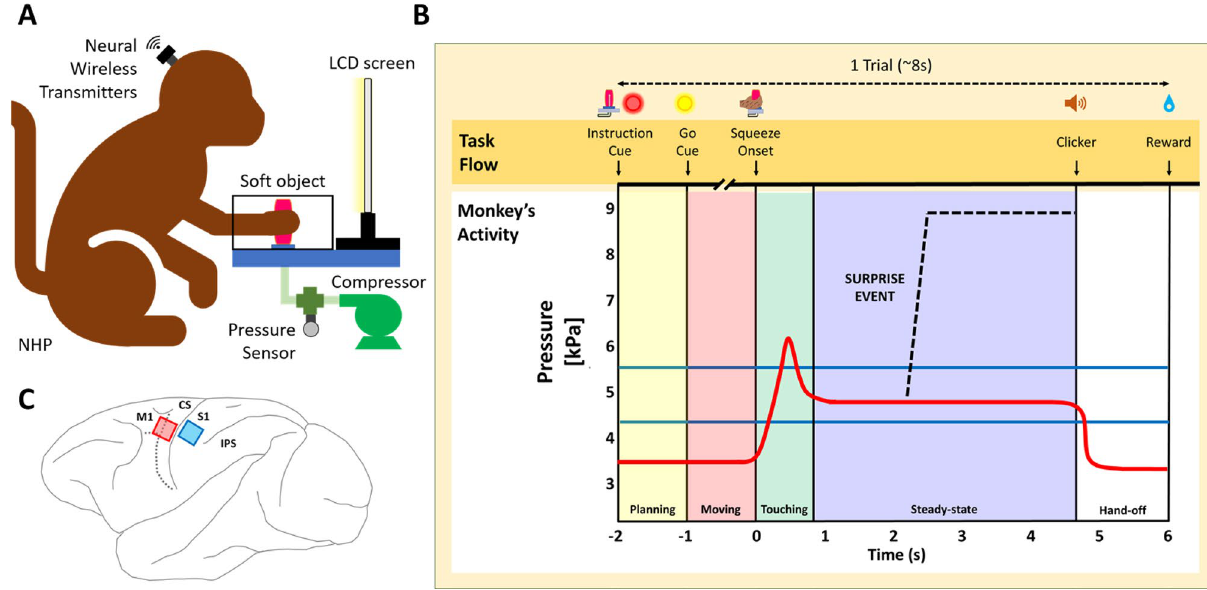
Figure 1. Experimental design. ( A ) Schematic of the experiment. Central to the design is a compliant cylindrical manipulandum composed of a soft polymer envelope which is internally pressurized from a hydraulic air compressor. The monkey sits in a custom-made chair and reaches for the manipulandum through an opening in a transparent window. Multichannel signals are collected simultaneously from a pair of microelectrode arrays (MEAs in S1 and M1) and transmitted wirelessly to nearby neural signal processing electronics. ( B ) Time course of the task. Top: Graphical representation of task flow. The task flow is separated into four stages: Movement Planning (Yellow rectangular panel), Movement, i.e. arm/hand reach (Pink panel), Touch and Grasp (Green panel), and Steady State squeeze (Blue panel). The solid red line represents trial averaged time varying pressure inside the manipulandum as the monkey first grasps and then squeezes the manipulandum to reach a steady-state. In addition to this ‘NORMAL’ task, the dashed black line shows schematically an abrupt elevation in the internal pneumatic pressure of the manipulandum introduced during the steady state, labeled as the ‘SURPRISE EVENT’ the onset of which was randomly timed from 2–5 s after the onset of Touch. The two blue horizontal lines define the target pressure range within which the monkey must maintain the force of hand squeeze in steady state to complete a successful trial. ( C ) Schematic of the approximate cortical location of the implanted intracortical MEAs. CS central sulcus, IPS intraparietal sulcus, M1 primary motor cortex, S1 primary somatosensory resting position for at least 1 s for the juice reward to start. The intertrial interval was 2–4 s. A trial was consid- ered successful if the monkey could complete all the steps. The monkeys were able to learn and adapt to the task quickly after a few weeks of training and were considered trained in this ‘NORMAL’ task if their performance was above 80% for 5 consecutive days. Once the monkeys were routinely performing the NORMAL task, we introduced an abrupt confound, unbe- knownst to the animals, in a series of random trials. The confound was a sudden reduction in the compliance of the manipulandum during the steady squeeze (dashed line in Fig. 1B) induced by increasing the level of the internal pressure in the manipulandum by approximately 4 kPa from its baseline value within ~ 200 ms and without any visual or auditory cue to the animal. Following this “SURPRISE EVENT”, the monkeys had to re-adjust the force of their squeeze to adapt to the new state of compliance so as to reach and maintain a new steady squeeze for up to another five seconds (guided by the LCD pressure indicator). The new acceptable range was 8–10 kPa, allowing for variability in the excess pressure applied to the manipulandum. The thick horizontal black stripe and the red indicator ball displayed on the LCD screen were shifted to new positions, accordingly. Intracortical microelectrode arrays. Following the training, each monkey was implanted with two 100-element microelectrode arrays (MEA, Blackrock Microsystems, Salt Lake City, UT, USA) targeting the hand representation of the primary somatosensory (S1) and the primary motor (M1) cortices, respectively (Fig. 1C). To locate the hand areas, we reconstructed a 3D model of the monkey’s head fusing their MRI and CT scan images. We combined the data while using the Macaque brain atlas and previous studies 20,21 to locate the implant sites. A large craniotomy (30 × 40 mm) was performed over the motor and somatosensory cortices. For both monkeys, the 4 × 4 mm 2 arrays were implanted about 1 mm away from and symmetrical to the central sulcus. We first located the central sulcus (CS) and intraparietal sulcus (IPS). The S1 array was implanted next to the tip of the IPS and the M1 array was located symmetrically to the CS. We sutured the dura and attached the bone flap using 3 titanium strips (Stryker). Each MEA consists of 96 electrodes with 400 um pitch, targeting layers IV/V and V of S1 (1-mm-long electrodes) and M1(1.5-mm-long), respectively. The monkeys were returned to the experiments following a recovery period of 2 weeks.